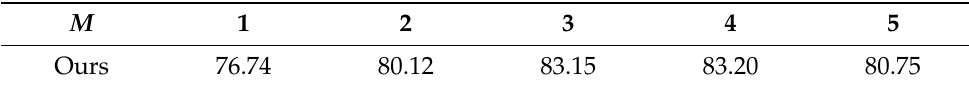
Table 6. Recognition accuracy (%) of the aerial scene classification using different numbers of early training models M